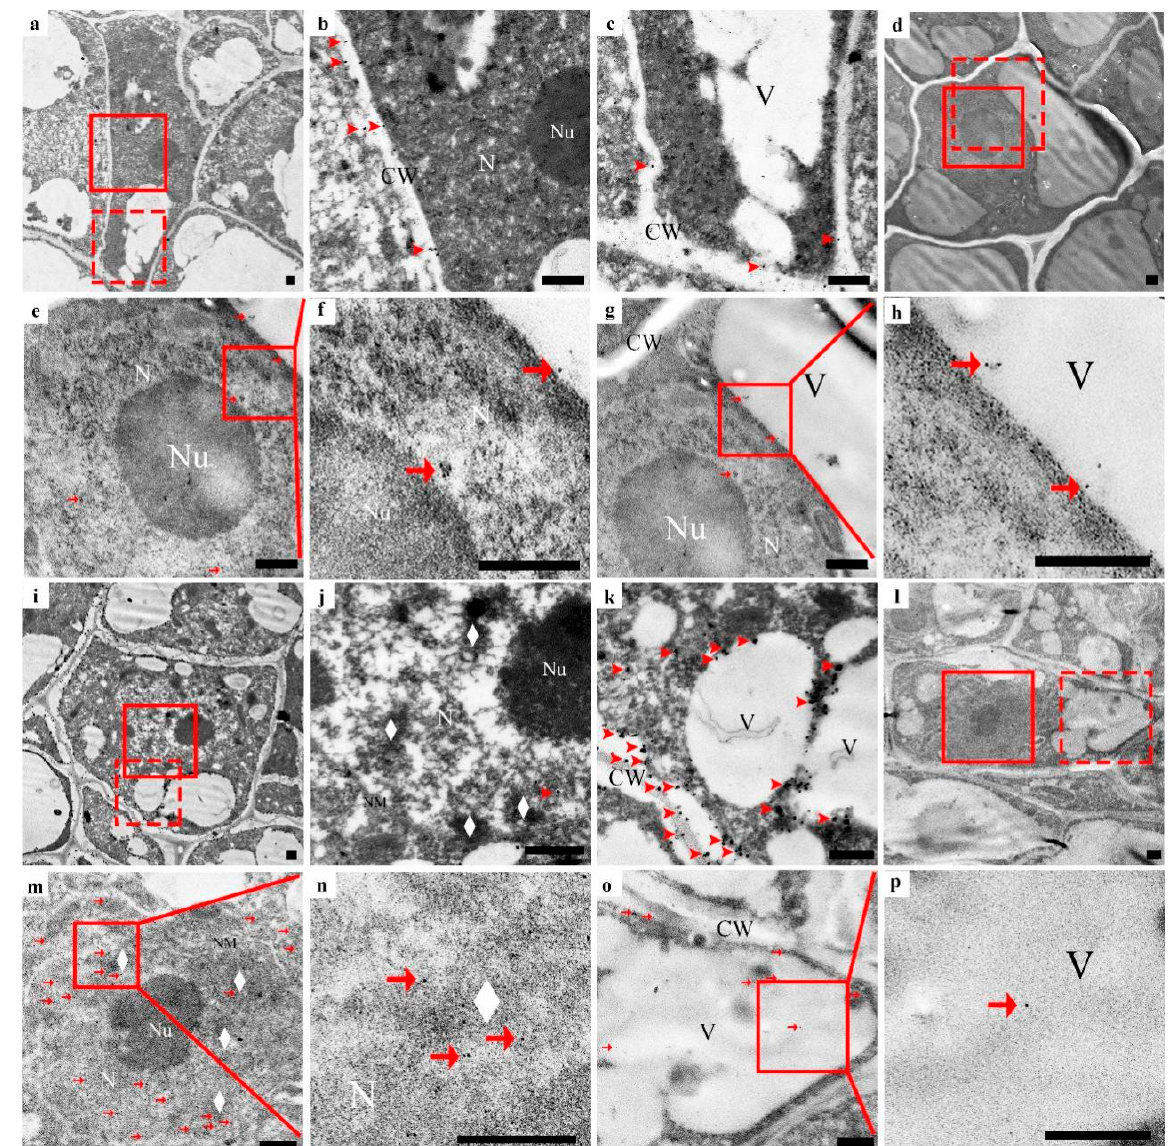
Figure 4. Zn 2+ ions subcellular localization ( a – c , i – k ) and CgENDO1 immunocytochemistry ( d – h , l – p ) during secretory cavity development of Citrus grandis ‘Tomentosa’ fruits. ( a ) Secretory cavity cells in the early initial cell stage. ( b ) Shows the solid line rectangle in ( a ) with a normal nuclear shape and dense nucleoplasm, and ( c ) shows the dotted line rectangle in ( a ) with a small number of silver particles only in the cell wall (arrowhead). ( d ) Shows the secretory cavity cells in the early initial cell stage, ( e ) shows the solid line rectangle of ( d ). ( f ) Shows the solid line rectangle of ( e ), the nucleoli is full, the nucleoplasm is dense, and a very small amount of immunogold particles are in the nucleus (arrow), and ( g ) shows the dotted line rectangle of ( d ). ( h ) Shows the solid line rectangle of ( g ), and a very small amount of immunogold particles are in the vacuole (arrow). ( i ) Central cells of the globulus of the secretory cavity in the middle initial cell stage. ( j ) Shows the solid rectangle in ( i ), the structure of the nucleoli is clear, the chromatin condenses (diamond), and a handful of silver particles are present in the nucleus (arrowhead). ( k ) Shows the dotted rectangle in ( i ), and the double nuclear membrane is clear. Most of the silver particles are in the cell wall, while a few are in vacuole and the cytoplasmic matrix (arrowhead). ( l ) Shows central cells of the globulus of the secretory cavity in the middle initial cell stage. ( m ) Shows the solid line rectangle in ( l ). ( n ) Shows the solid line rectangle of ( m ). The structure of the nucleoli is clear, there is a clear double nuclear membrane and the chromatin condenses (diamond). A more scattered distribution of immunogold particles into the nucleus, and the condensed chromatin has immunogold particles (arrow), ( o ) shows the dotted rectangle in ( l ). ( p ) Shows the solid line rectangle of ( o ), a few of the immunogold particles diffused in the vacuole and the cytoplasmic matrix (arrow). CW: Cell wall; N: Nucleus; NM: Nuclear membrane; Nu: Nucleolus; V: Vacuole. Bars = 500